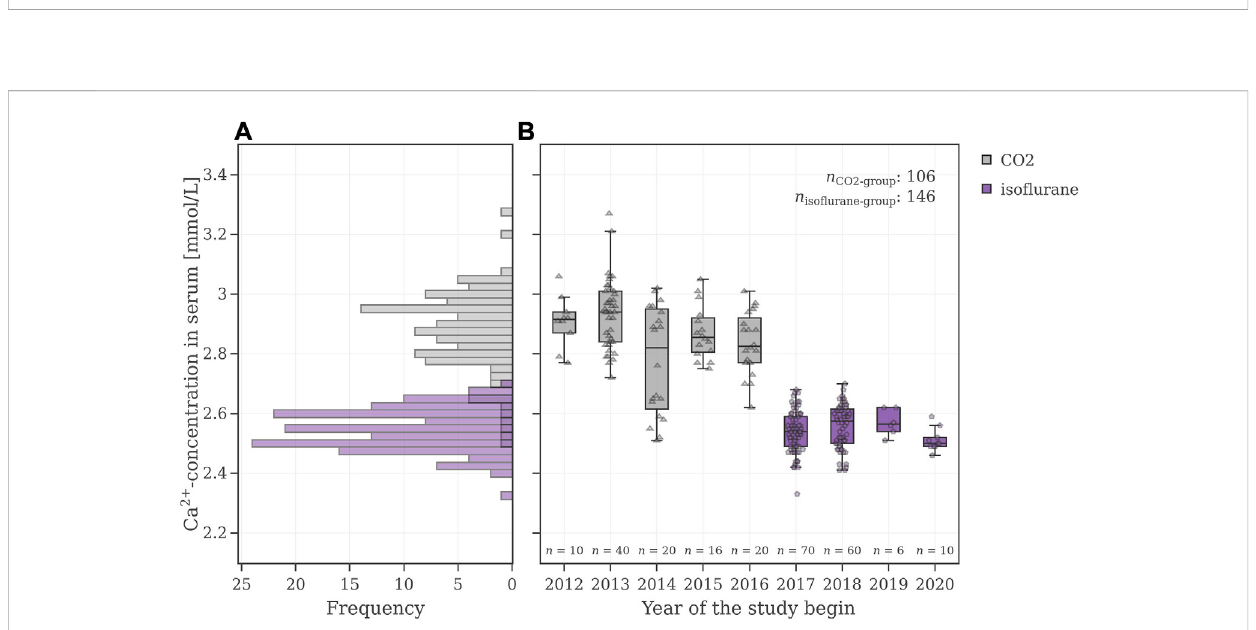
FIGURE 5 (A) Calcium value distributions of male Wistar-rats (B) Box plots of these calcium levels with respect to the study year. The CO 2 -group is colored grey, and the iso fl urane-group is colored